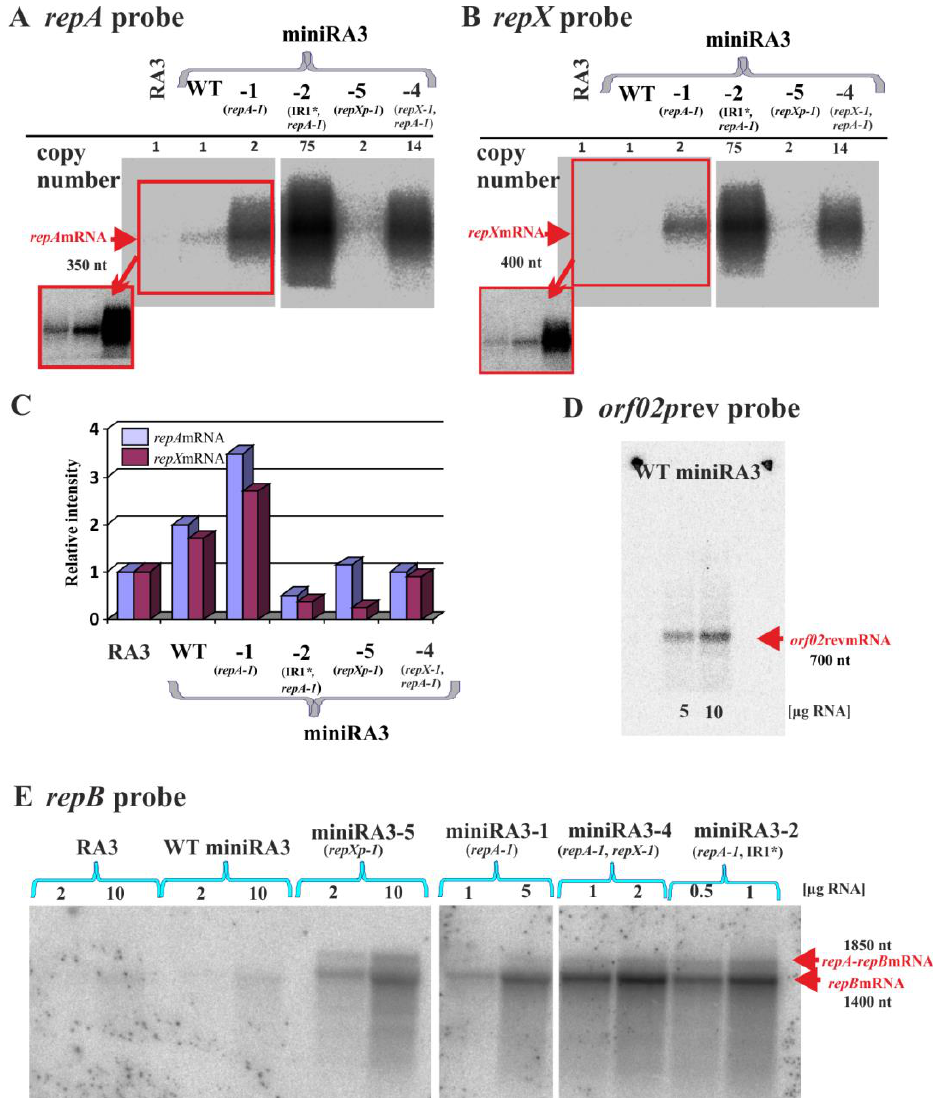
Figure 7. Northern analysis of the transcripts in the RA3 replication module. 0.5 – 12 μ g of total RNA isolated from the transformants of DH5α strain with RA3, WT miniRA3 , or four miniRA3 mutants was denatured and separated on the denaturing agarose gels. The RNA from the gels was transferred onto a nitrocellulose membrane that was hybridized with four different radioactive probes. ( A ) and ( B ) DNA-RNA hybridization to visualize repA mRNA and repX mRNA, respectively. Of the total RNA, 12 µ g was used in experiments. Mutations present in the minireplicons are indicated. The copy number of the analyzed plasmids is shown above the autoradiographs. The parts of gels in the insets demonstrate the longer exposures. ( C ) The diagram demonstrates the relative intensity of signals from gels ( A , B ) in comparison to RA3 mRNAs. Photostimulated luminescence (PSL/mm 2 ) detected for repA mRNA and repX mRNA was normalized to the single plasmid copy. ( D ) Visualization of orf02 rev mRNA produced from WT miniRA3 by DNA–RNA hybridization. ( E ) Visualization of the repB transcripts in RNA–RNA hybridization. Various amounts of RNA were tested as indicated for each